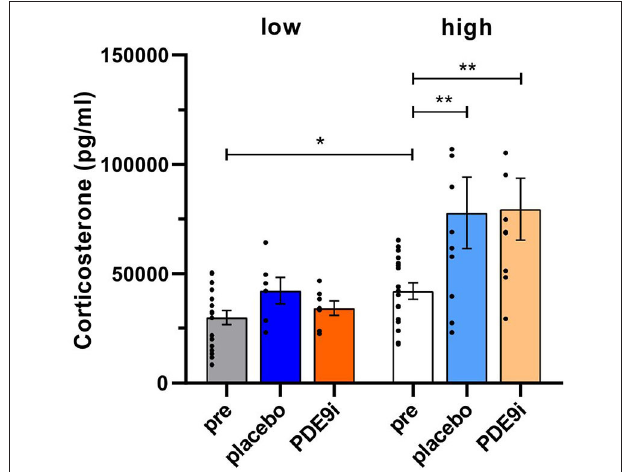
FIGURE 3 | Corticosterone levels in low and high compensators before and after treatment with either placebo or PDE9i. Prior to treatment, low compensators had lower corticosterone levels in comparison to high compensators. Significantly elevated corticosterone levels were found only in high compensators but not in low compensators after treatment with either placebo or PDE9i. However, no significant differences were observed between the two post-treatment conditions in either high or low compensators. Mean ± SEM. * p < 0.05 (two-tailed t-test pre low vs. pre high), ** p < 0.01 (the Bonferroni’s multiple comparison test for high